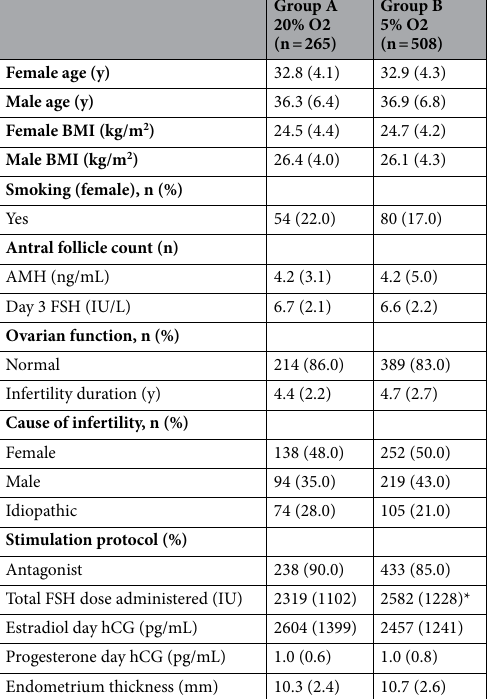
Table 1. Demographic and clinical characteristics of patients randomized at Day 0. y years, n number, BMI body mass index. Data are presented as mean (SD) or n (%). * P <